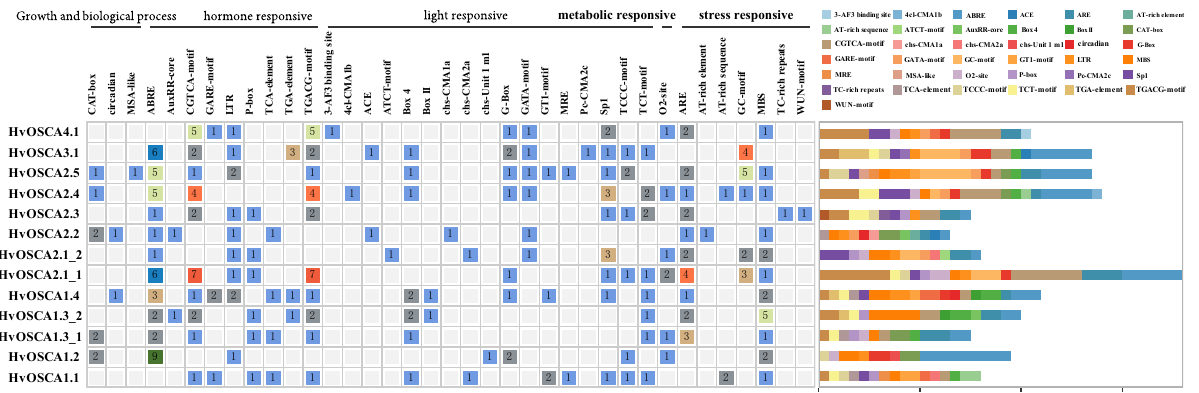
Figure 3. Cis-elements found in the promoter region of HvOSCAs . ( Left ): The number and function classification of cis-acting element in each HvOSCA genes. ( Right ): Distribution of 37 identified cis-acting elements in each HvOSCA ; elements are represented by the boxes in different